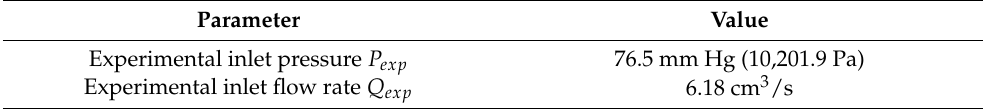
Table 4. Experimentally obtained input parameters for simulation of CHN03.